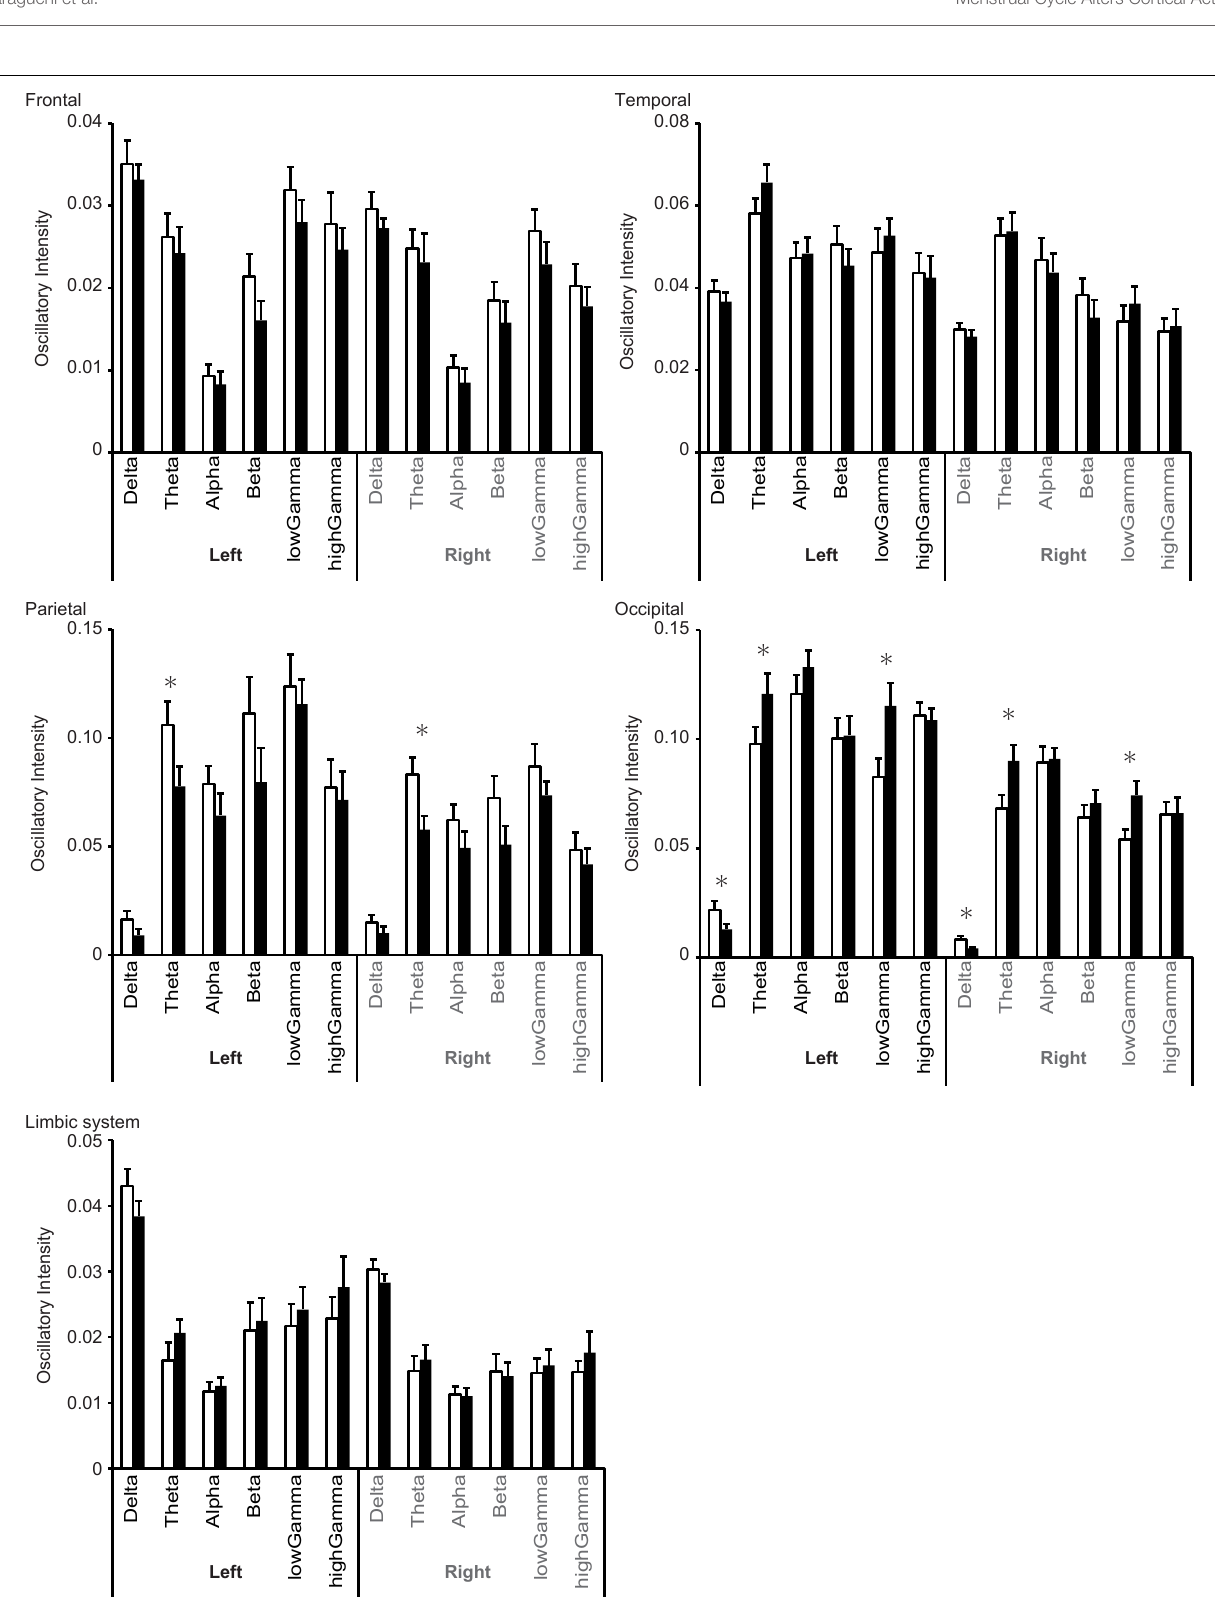
Frontiers in Human Neuroscience |